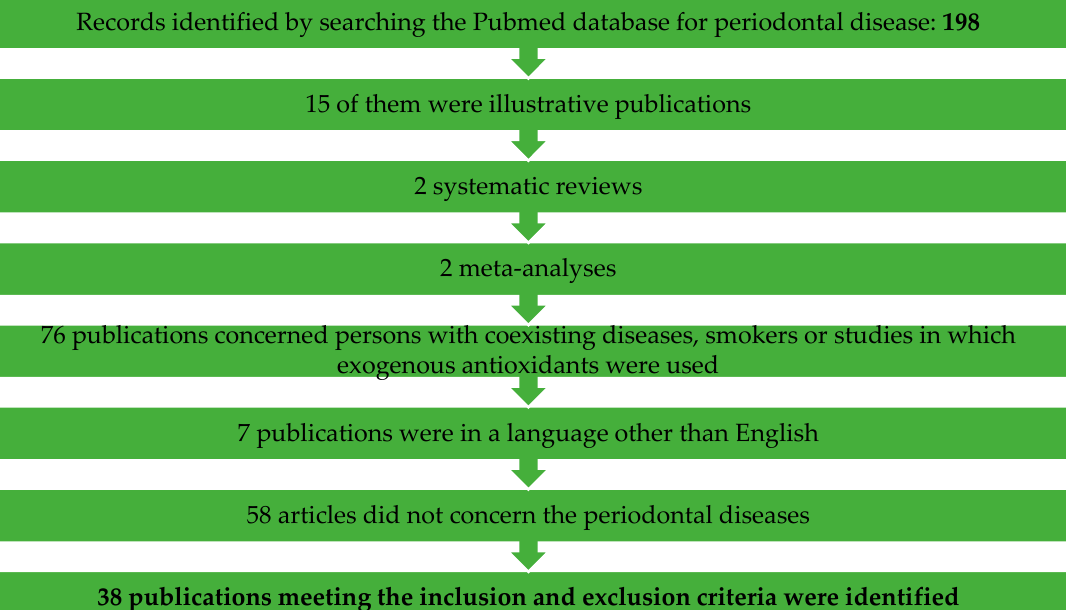
Figure 5. Flow chart of the study selection process for the systematic review regarding caries.